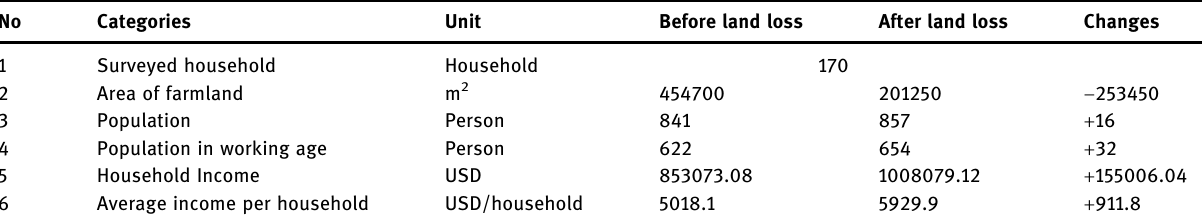
Table 1: General information on labor and income of surveyed